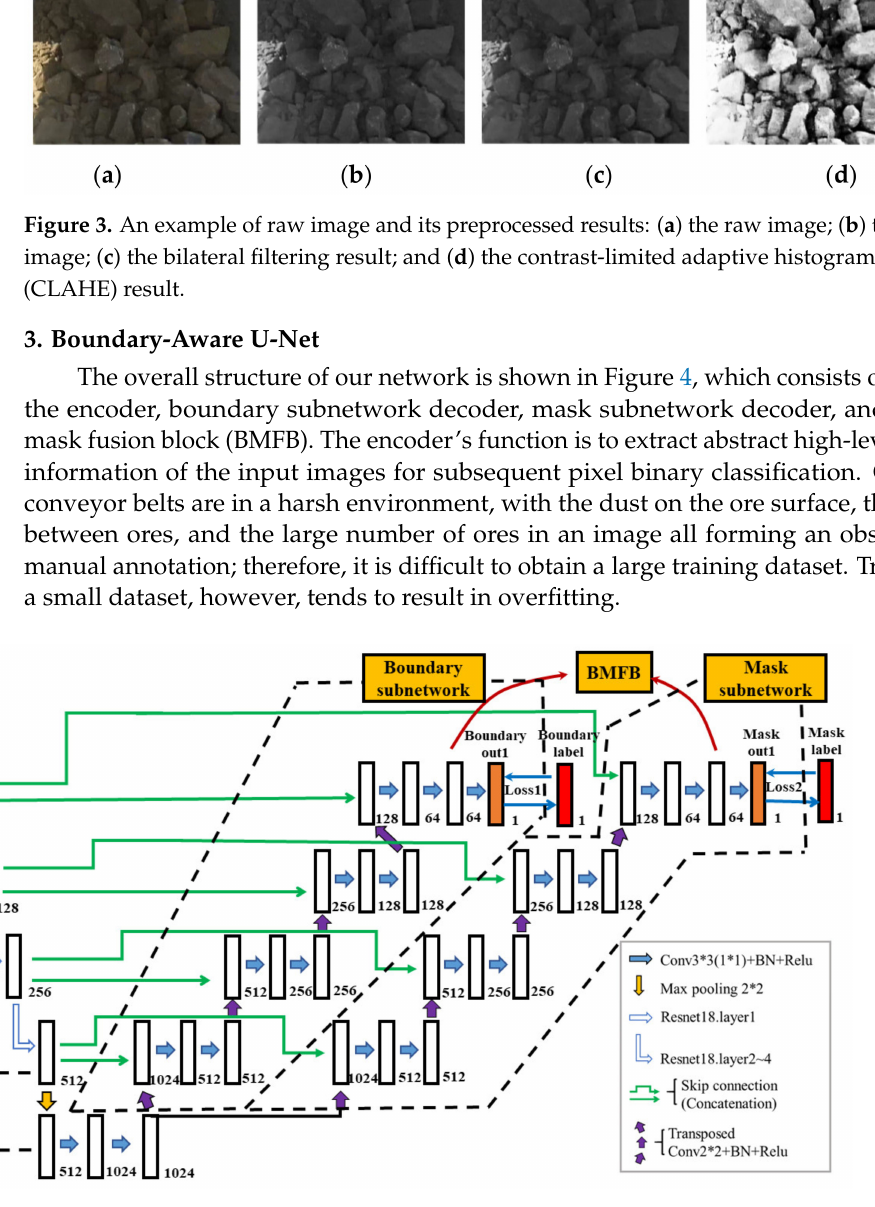
Figure 4. Network structure of the boundary-aware